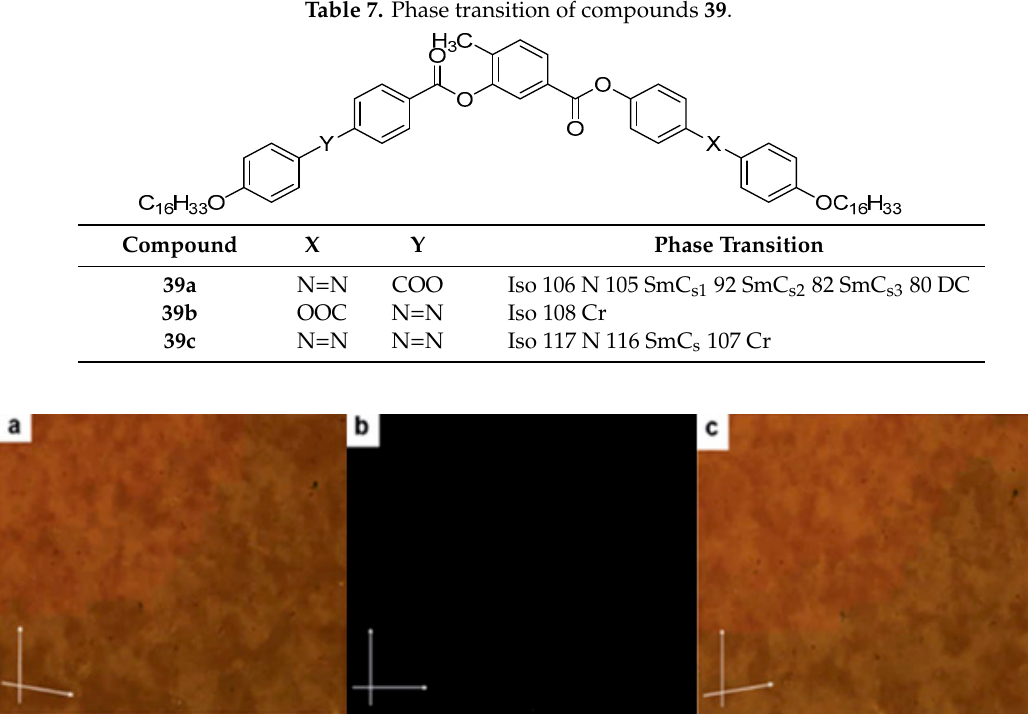
Table 7. Phase transition of compounds 39 .